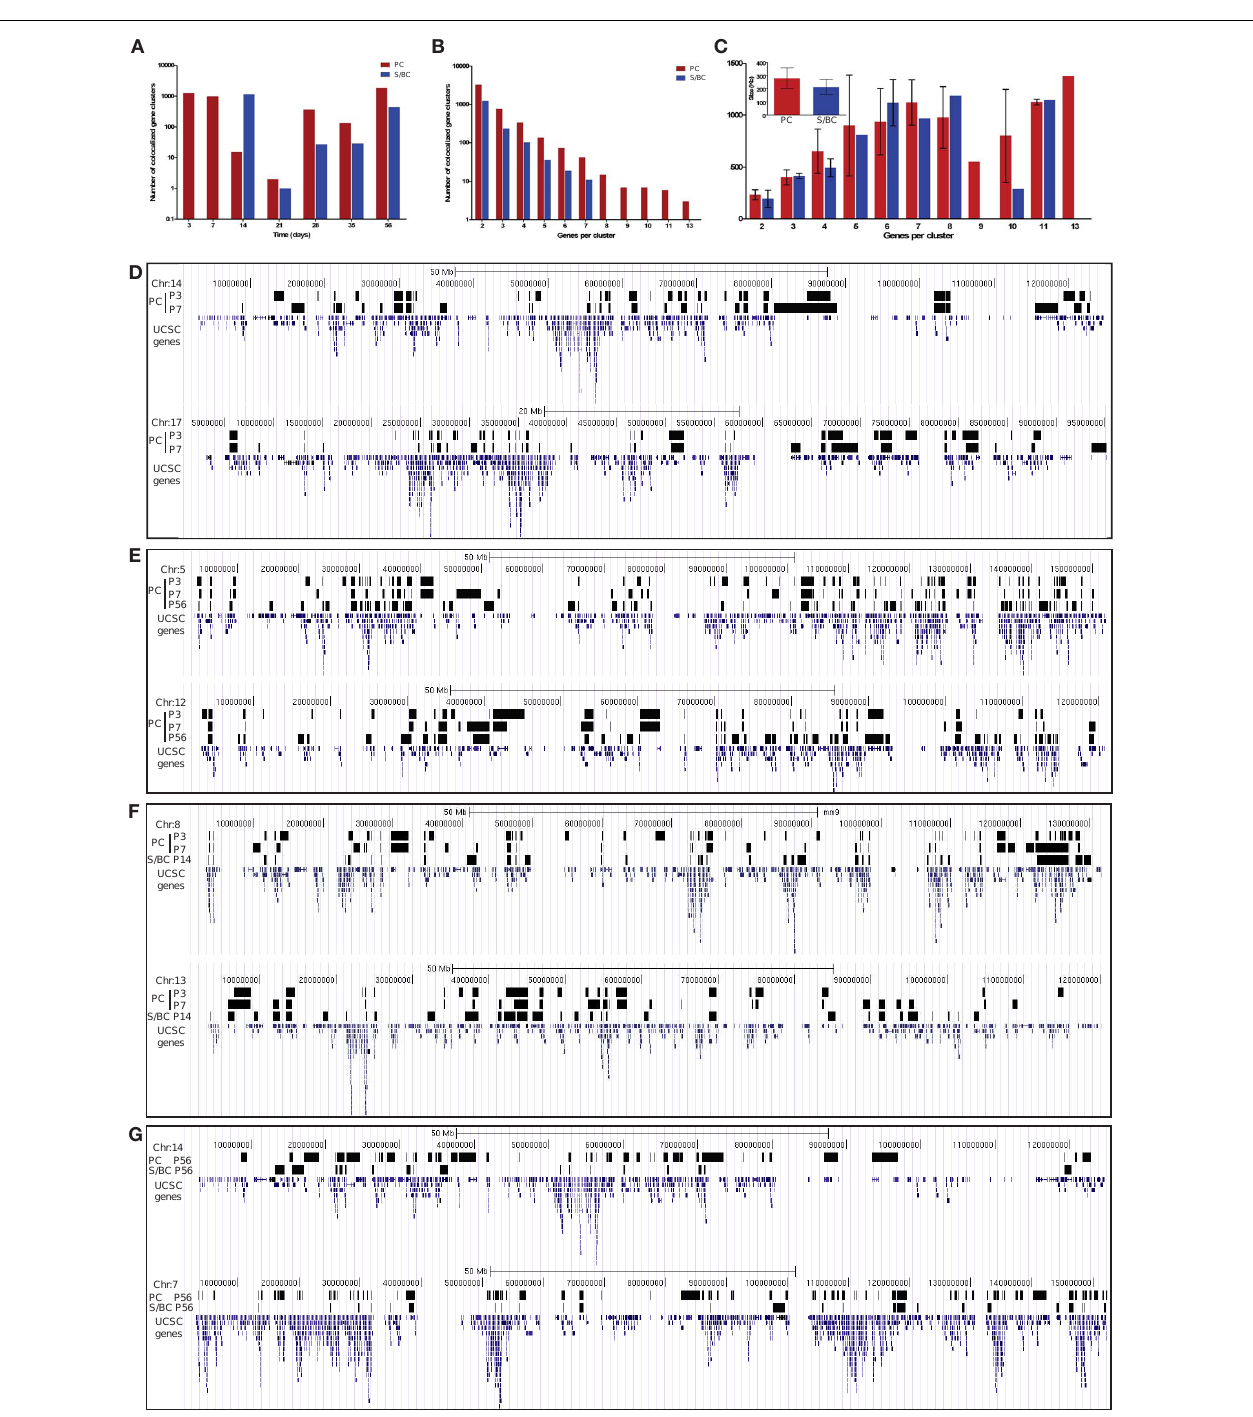
and ending ORFs in UCSC genome browser (see UCSC track files in BED format Table S1 in Supplementary Material for PC and Table S2 in Supplementary Material for S/BC). Certain cluster groups are stable between developmental stages P3 and P7 in PCs [ (D) , see also TableA1 in Appendix]. Co-localized clusters can re-emerge in late-developmental stages as shown in PC cell by comparing the P3 and P7 time points with P56 (E) . Representative common clusters across cell-types during early postnatal developmental stage (F) . Few such clusters are common between cell-types in late-adult stages suggesting the maintenance of a “locked-in” differentiated state (G)